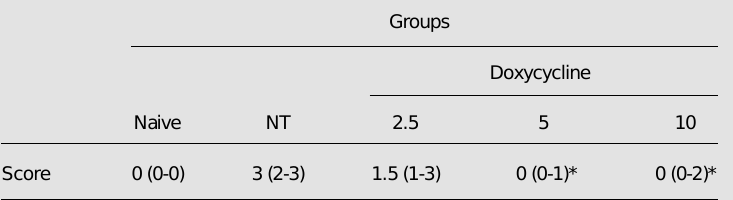
Table 1. Effect of doxycycline (2.5, 5 or 10 mg kg -1 day -1 ) on histological changes in rats subjected to